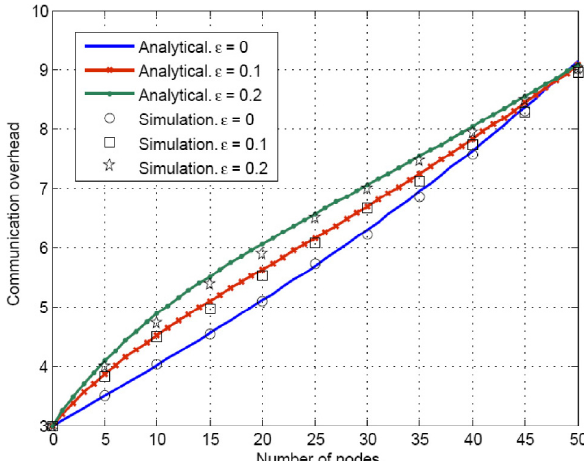
Figure 9. Communication overhead of the IPAA protocol as a function of network size with message loss rate as a parameter.